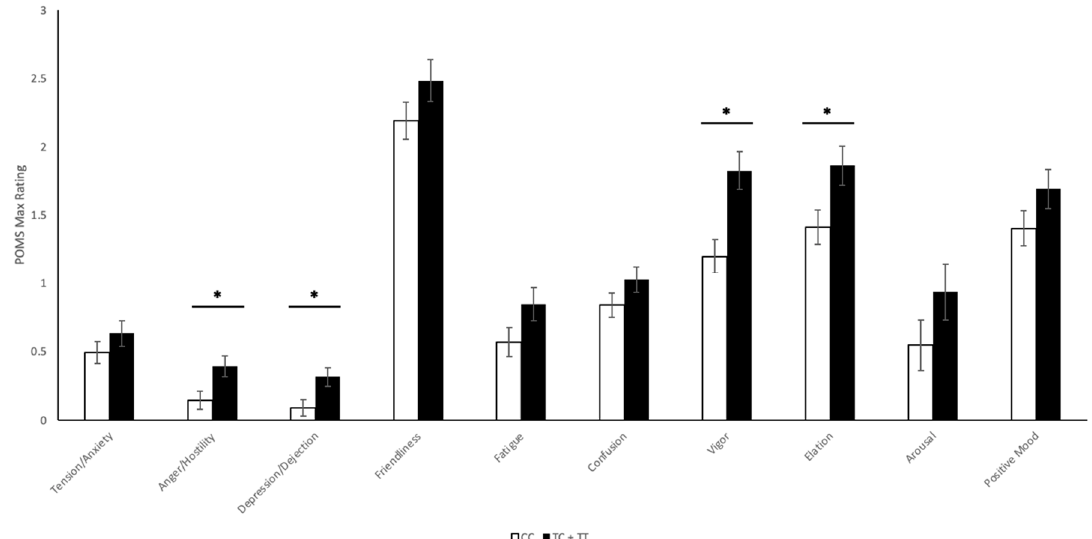
Figure 4. CNR1 rs1049353 Aggregate Profile of Mood States Maximum Values. Unadjusted maximum Profile of Mood States (POMS) questionnaire results (measured on a scale of 0–4), measured at baseline and 1 h post-cannabis exposure of n = 52 subjects, separated by rs1049353 genotype: Tension/Anxiety ( p = 0.261), Anger/Hostility ( p = 0.018), Depression/Dejection ( p = 0.016), Friendliness ( p = 0.160), Fatigue ( p = 0.087), Confusion ( p = 0.155), Vigor ( p = 0.001), Elation ( p = 0.021), Arousal ( p = 0.168), and Positive Mood ( p = 0.146). * p < 0.05, TC + TT vs. CC. Split-plot ANOVA analyses were con-